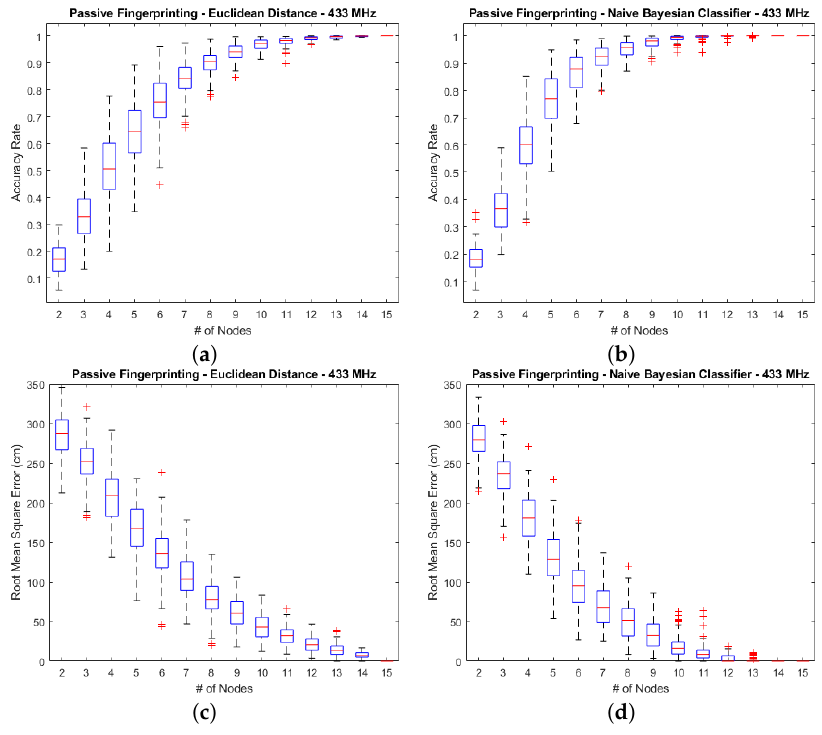
Figure 5. Box plots of the accuracy rates and root mean square distance errors based on 433 MHz data. ( a ) and ( b ) show the accuracy rates for respectively the Euclidean distance-based and naive Bayesian classifier-based methods, while ( c ) and ( d ) show the root mean square distance errors for both approaches.